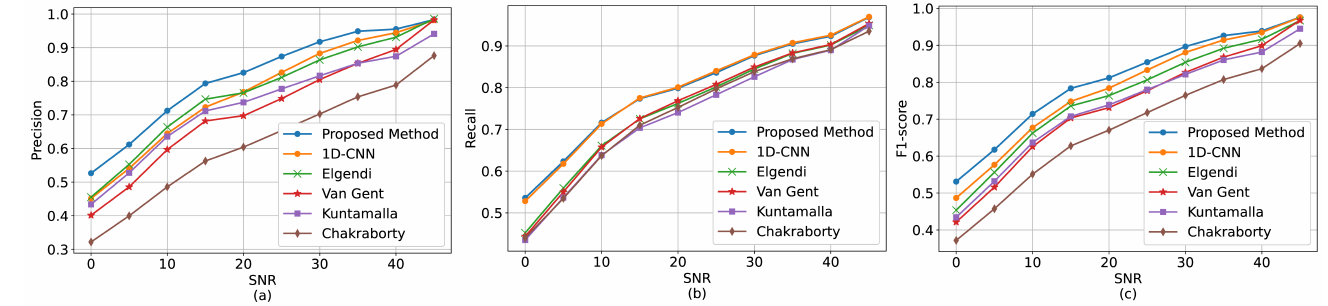
Figure 14. Performance comparison between the methods. ( a ) Precision, ( b ) recall, and ( c ) F1-score at different noise